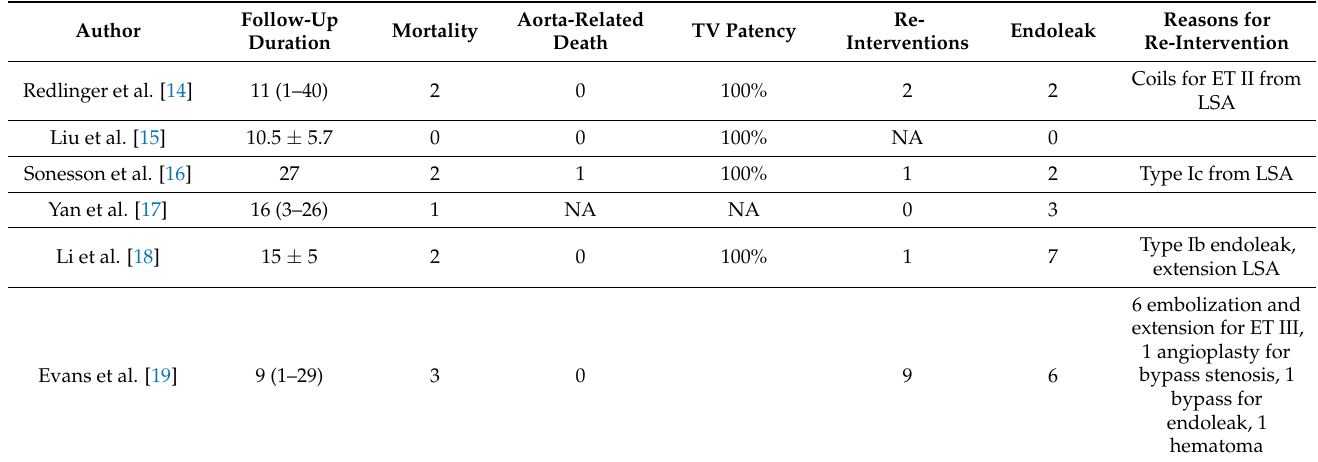
Table 4. Follow-up data including mortality and re-intervention rates in patients managed with in situ laser